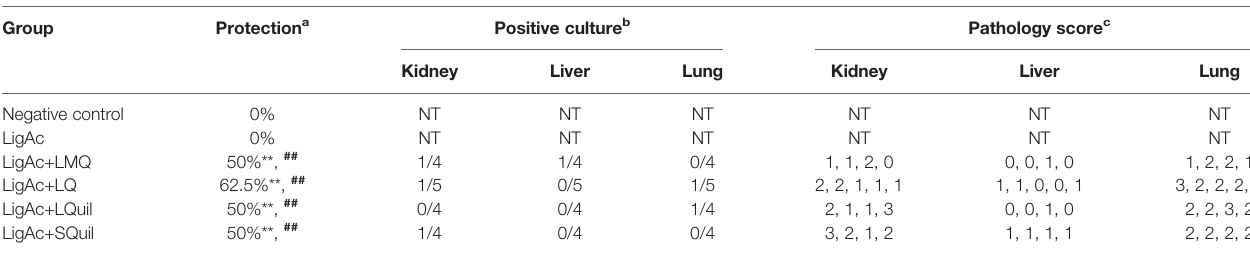
TABLE 1 | Protection conferred by LigAc vaccine formulations. Group